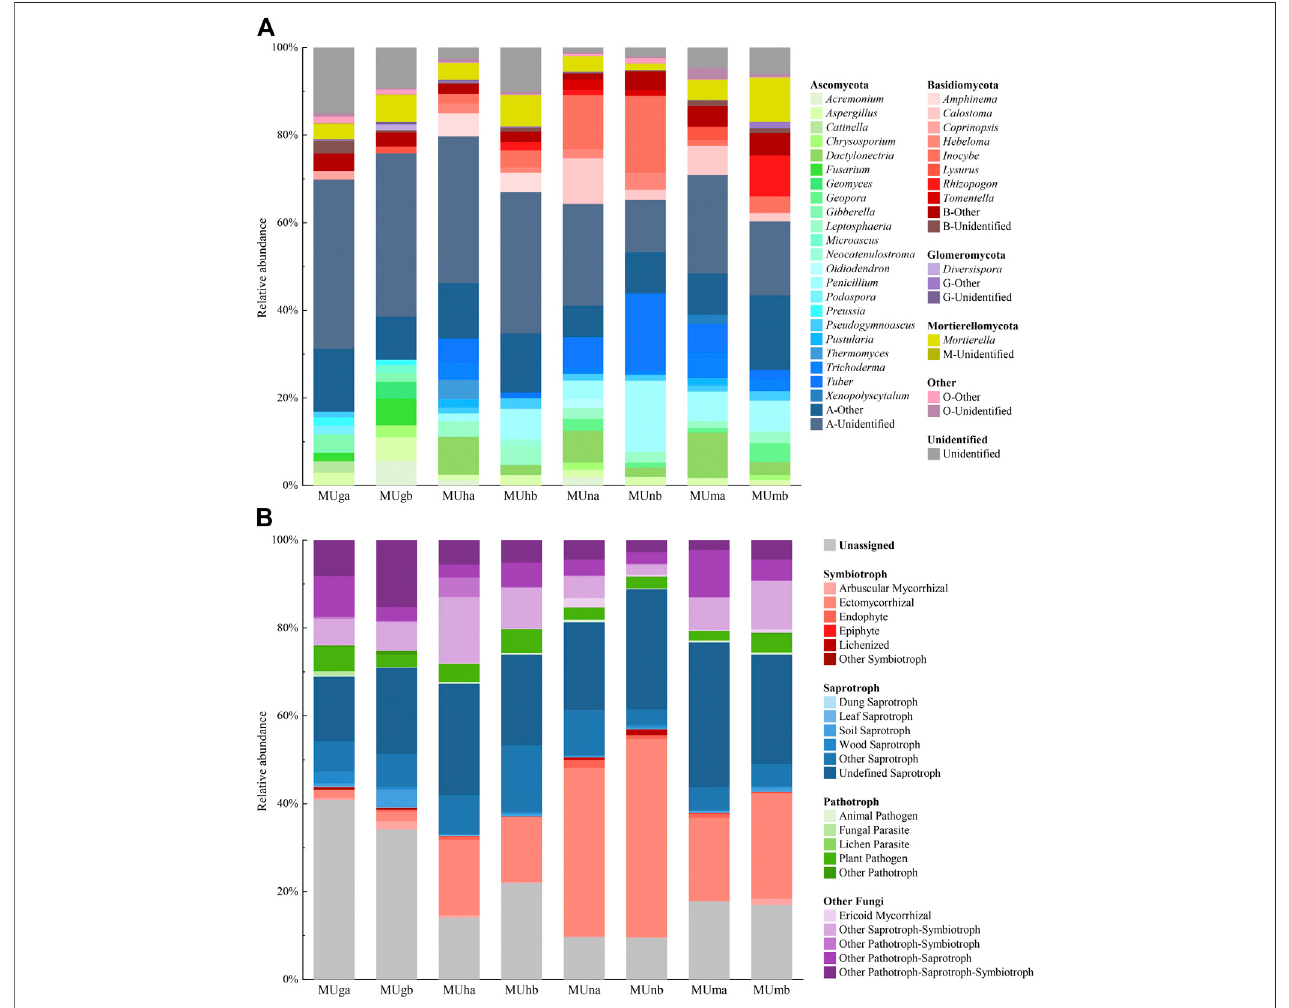
FIGURE 3 | Distribution and relative abundance of soil fungal (A) taxonomic and (B) functional groups in different soil depths trough revegetation durations. Genera > 1.00% were listed.